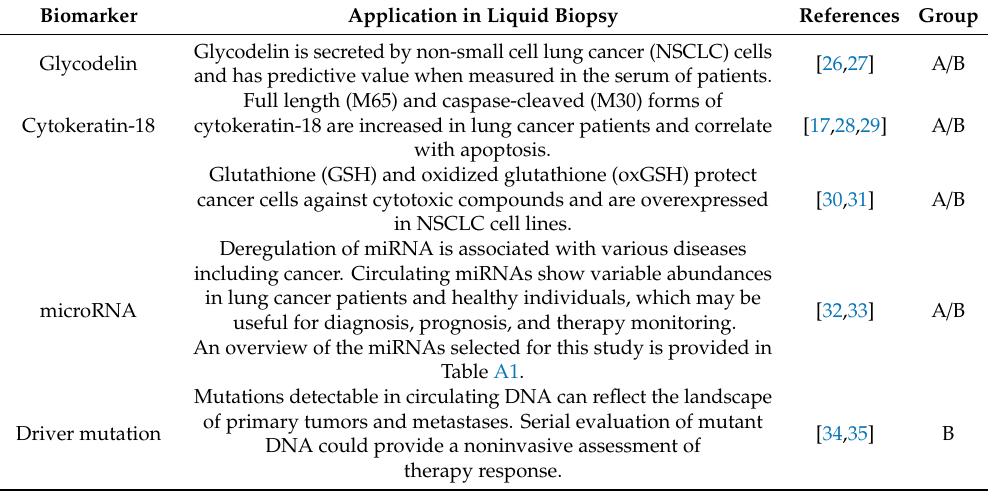
Table 2. Biomarkers. Overview of investigated